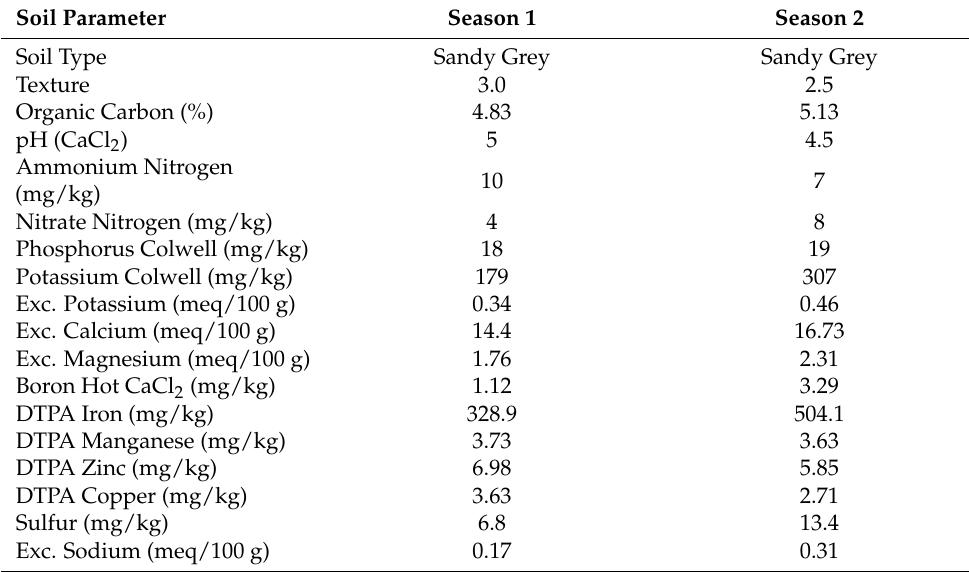
Table 2. Soil properties and nutrient content during both